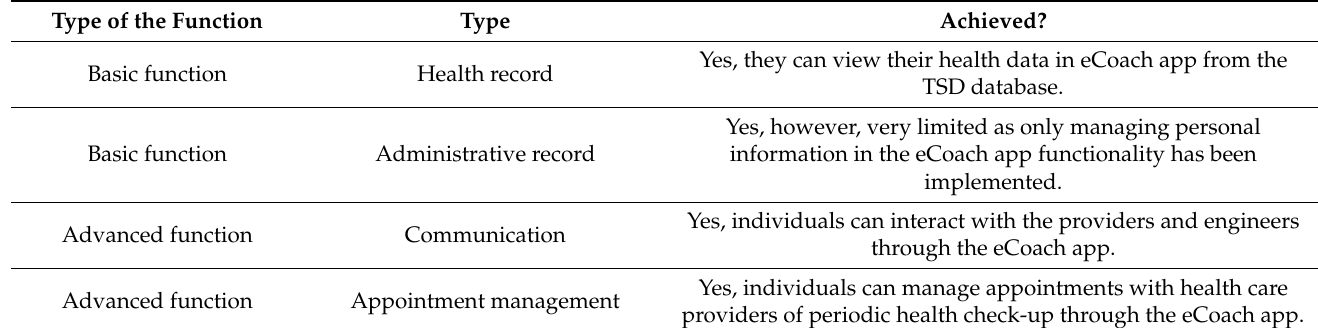
Figure 5. Mobile PHR view of participant’s observational data on different date for self-management as an example of supporting the FHR-S FM functionality (PH.2.5). Table 5. The achieved functionalities as compared to the identified functionalities [48].